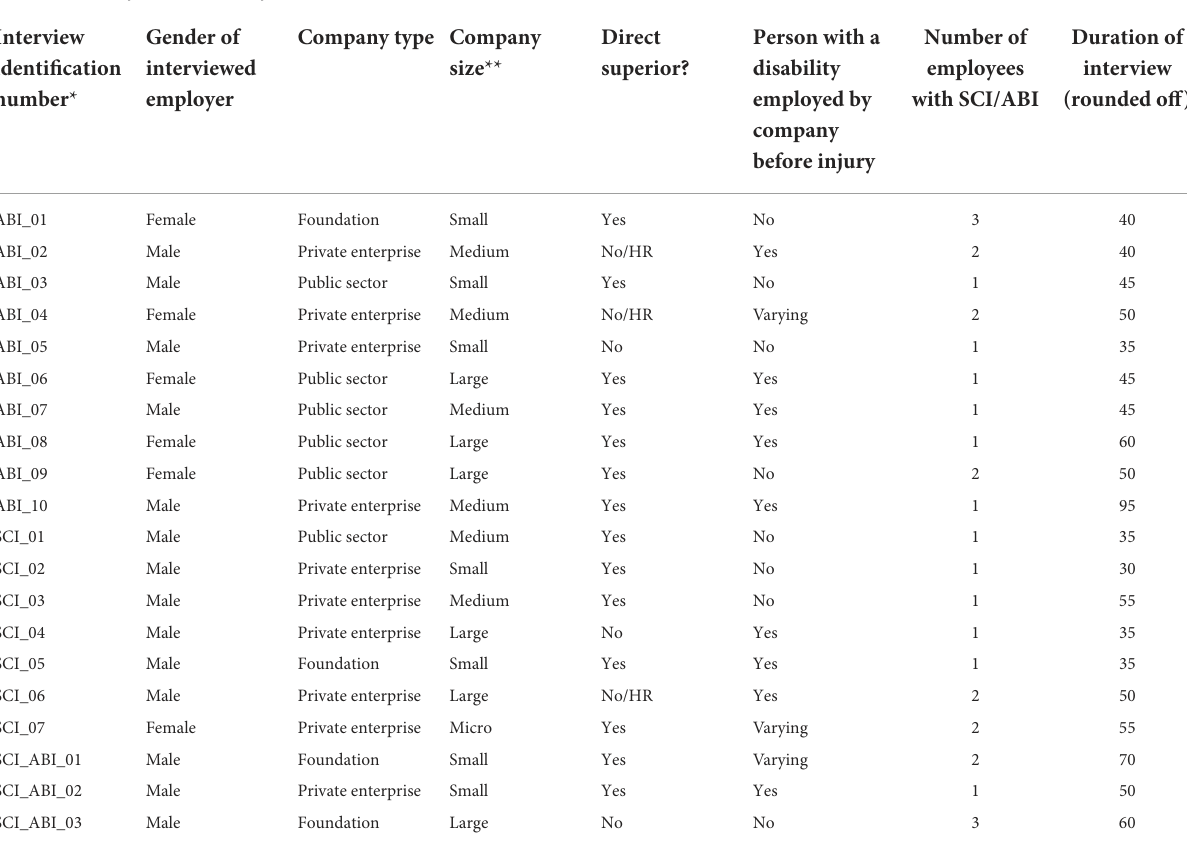
TABLE 1 Description of the